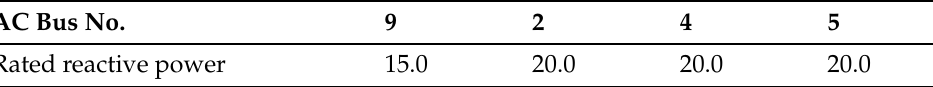
Figure 3. IEEE 14-bus test system with a radial three-converter HVDC multiterminal [15]. The parameters of the AC system are shown in Tables 4–8. Table 4. Capacitor shunt compensation (MVAr).